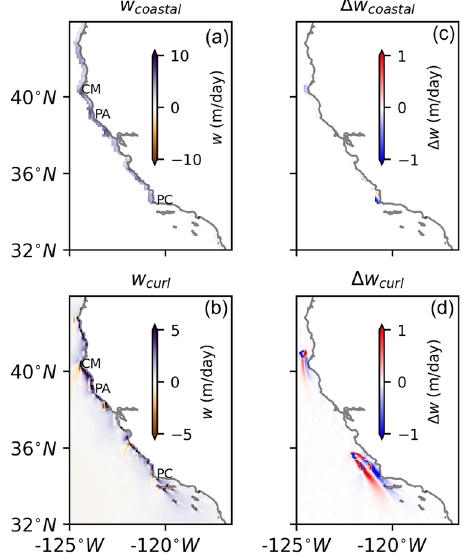
Fig. 4 Comparison of vertical velocities from coastal and curl-driven upwelling. Seasonally averaged estimates of a coastal and b curl-driven upwelling computed from wind fi elds during spring for the baseline case. Marked on the maps are Cape Mendocino (CM), Point Arena (PA), and Point Conception (PC). Differences in wind-driven vertical velocity estimates (turbines minus baseline) are shown for c coastal and d curl- driven upwelling.